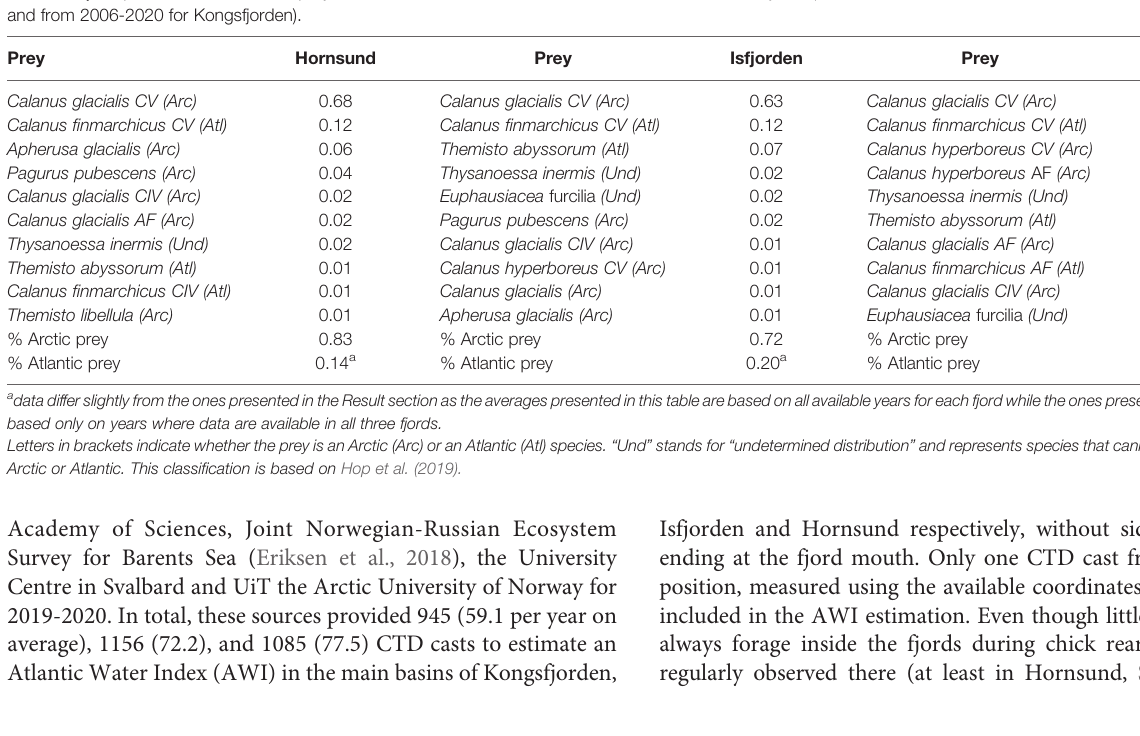
TABLE 2 | Proportion of the ten main prey items in the little auk chick diet in three western Svalbard fjords (based on data from 2005-2020 for Hornsund and Isfjorden and from 2006-2020 for Kongsfjorden). Prey Hornsund Prey Isfjorden Prey Kongsfjorden Calanus glacialis CV (Arc)